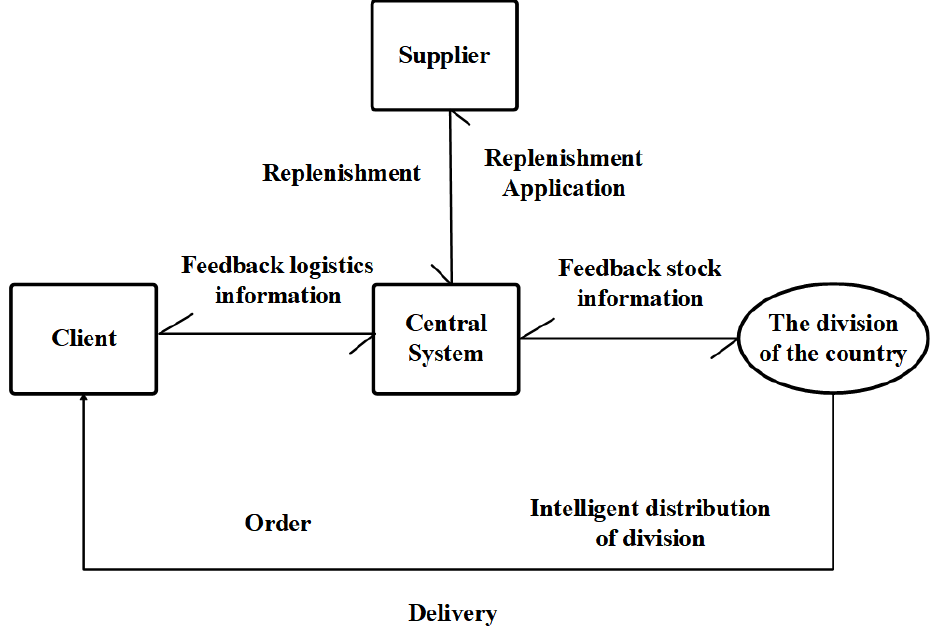
Figure 1. The operation flow of the cloud